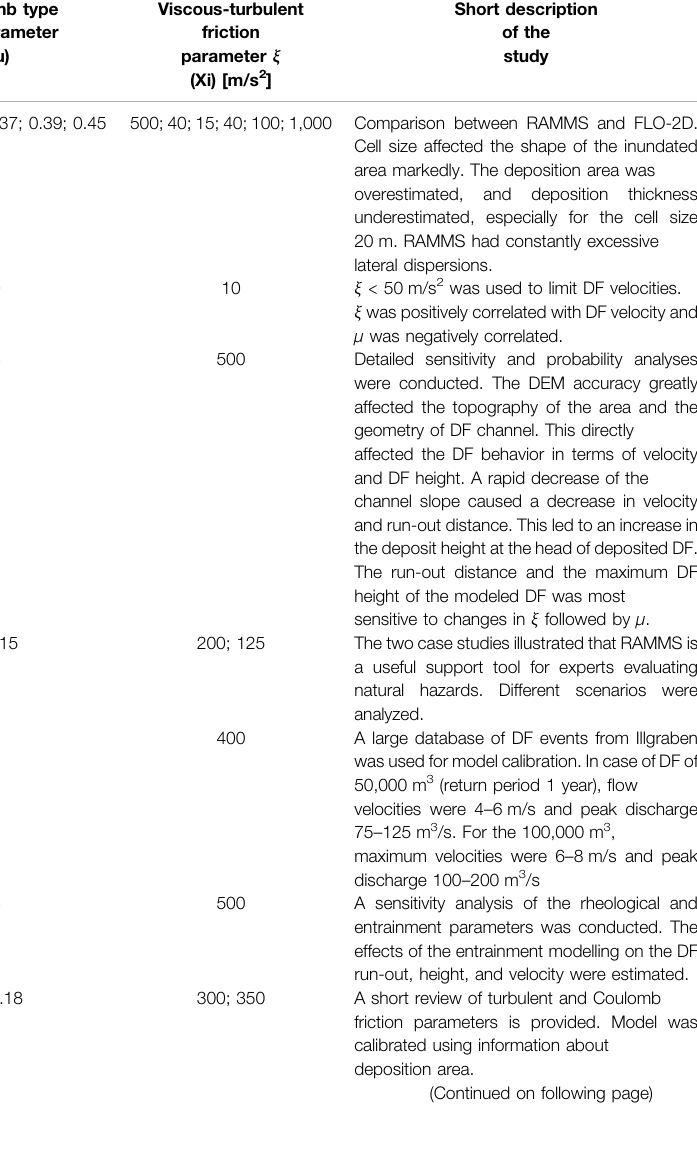
Cesca and D ’ Agostino